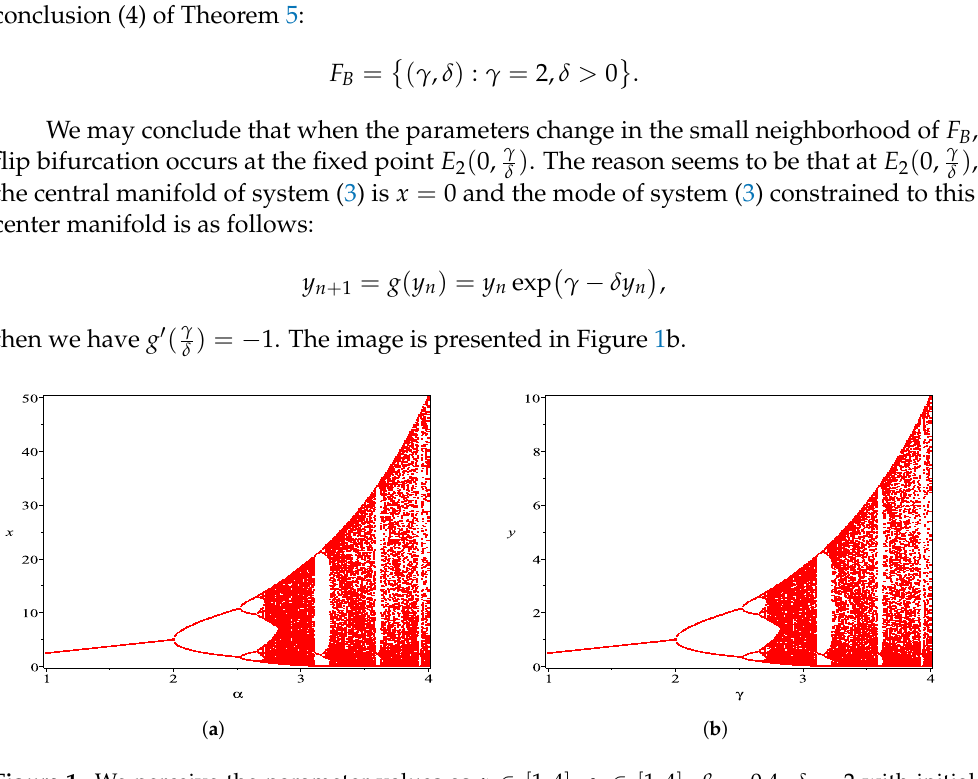
Figure 1. We perceive the parameter values as α ∈ [ 1,4 ] , γ ∈ [ 1,4 ] , β = 0.4, δ = 2 with initial value ( x 0 , y 0 ) = ( 0.15,0.2 ) . ( a ) Flip bifurcation diagrams of E 1 ( α ) of E 2 ( 0, γ δ